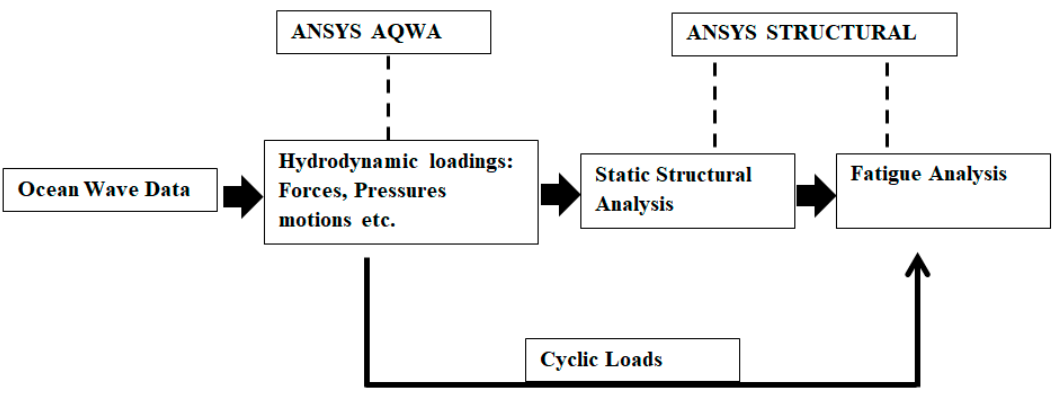
Figure 7. Structural design process.